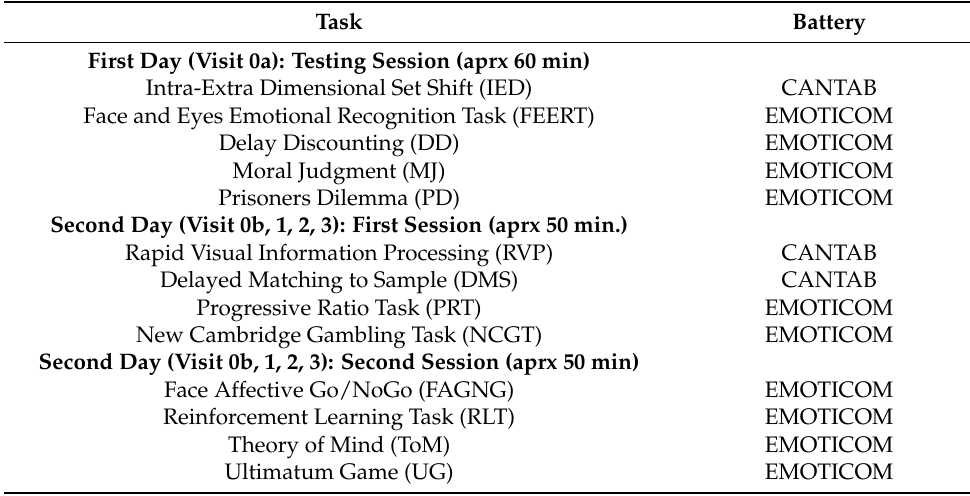
Table 4. Neuropsychological